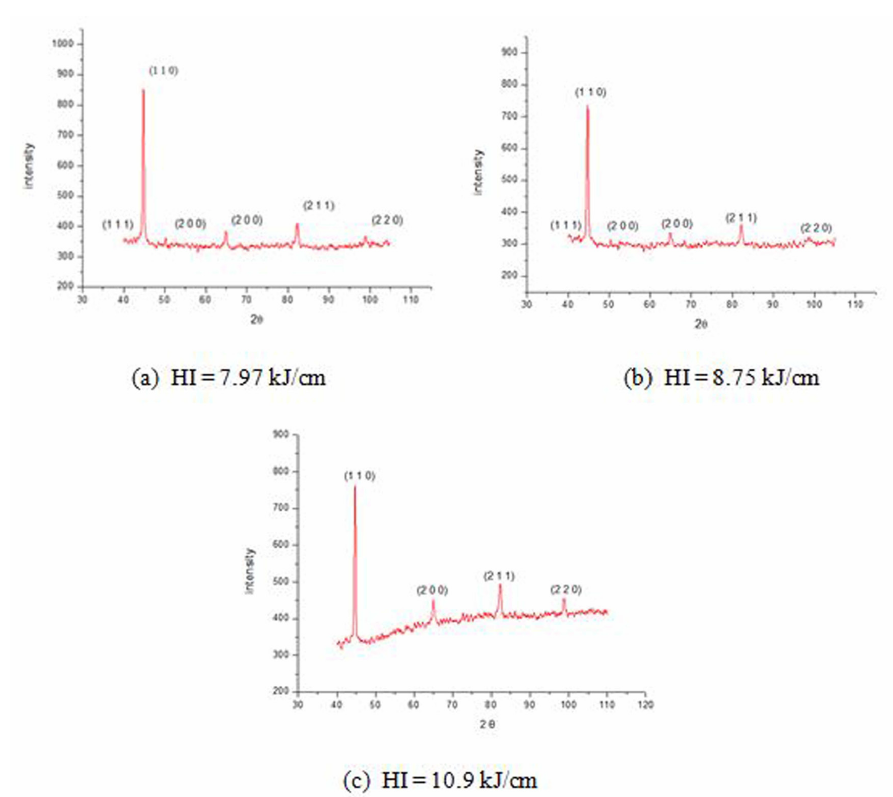
Figure 4. (a-c) The microstructure of HAZ near to fusion line under different heat input